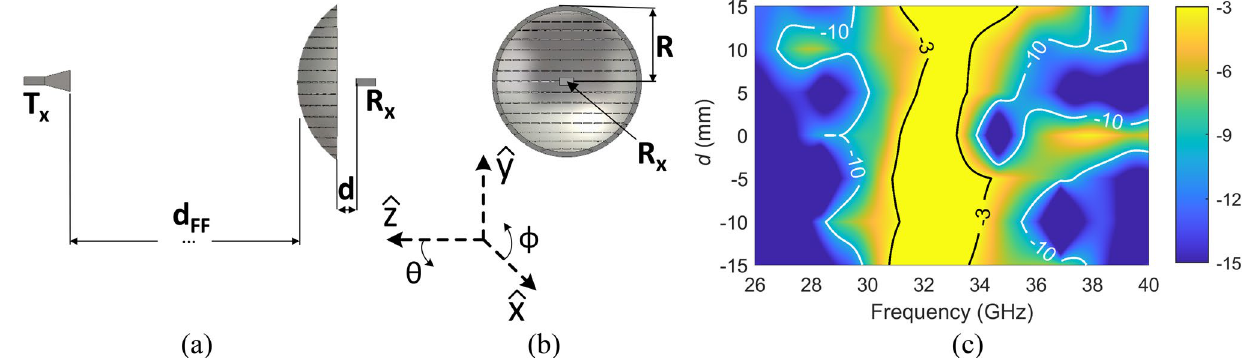
Figure. 2. (a) Side view (YZ plane) of the conformal FSS; (b) view from the receiver (XY plane); and (c) simulated S21 of the conformal FSS as a function of distance and frequency, with contour lines indicates the -3 dB and -10 dB transmission